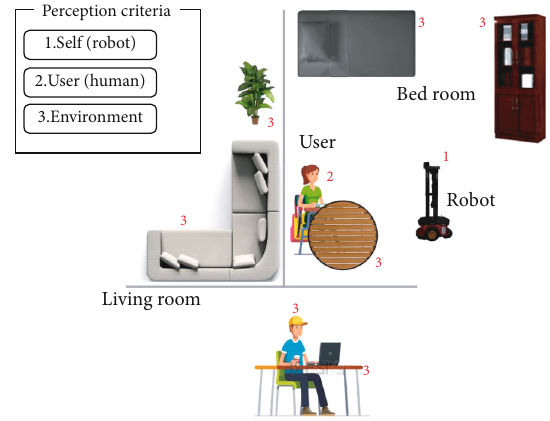
Figure 1: An example domestic environment is shown. In this scenario, the user is involved in a desk activity in the bed room. In order to understand the whole situation, the robot has to be knowledgeable on three aspects: itself, the user, and the surrounding environment. Factors related to these three aspects are marked as 1,2, and 3,